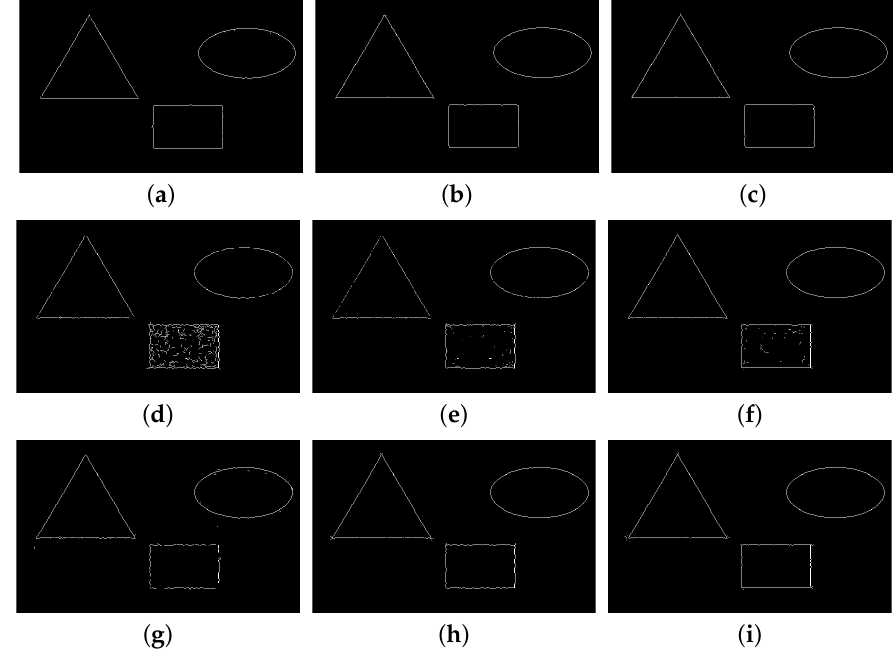
Figure 15. Edge binary maps on the simulated SAR images (Step and Roof), from left to right is the result of the one-look, three-look, and six-look simulated images. ( a – c ) SAR-PC; ( d – f ) PC; ( g – i )